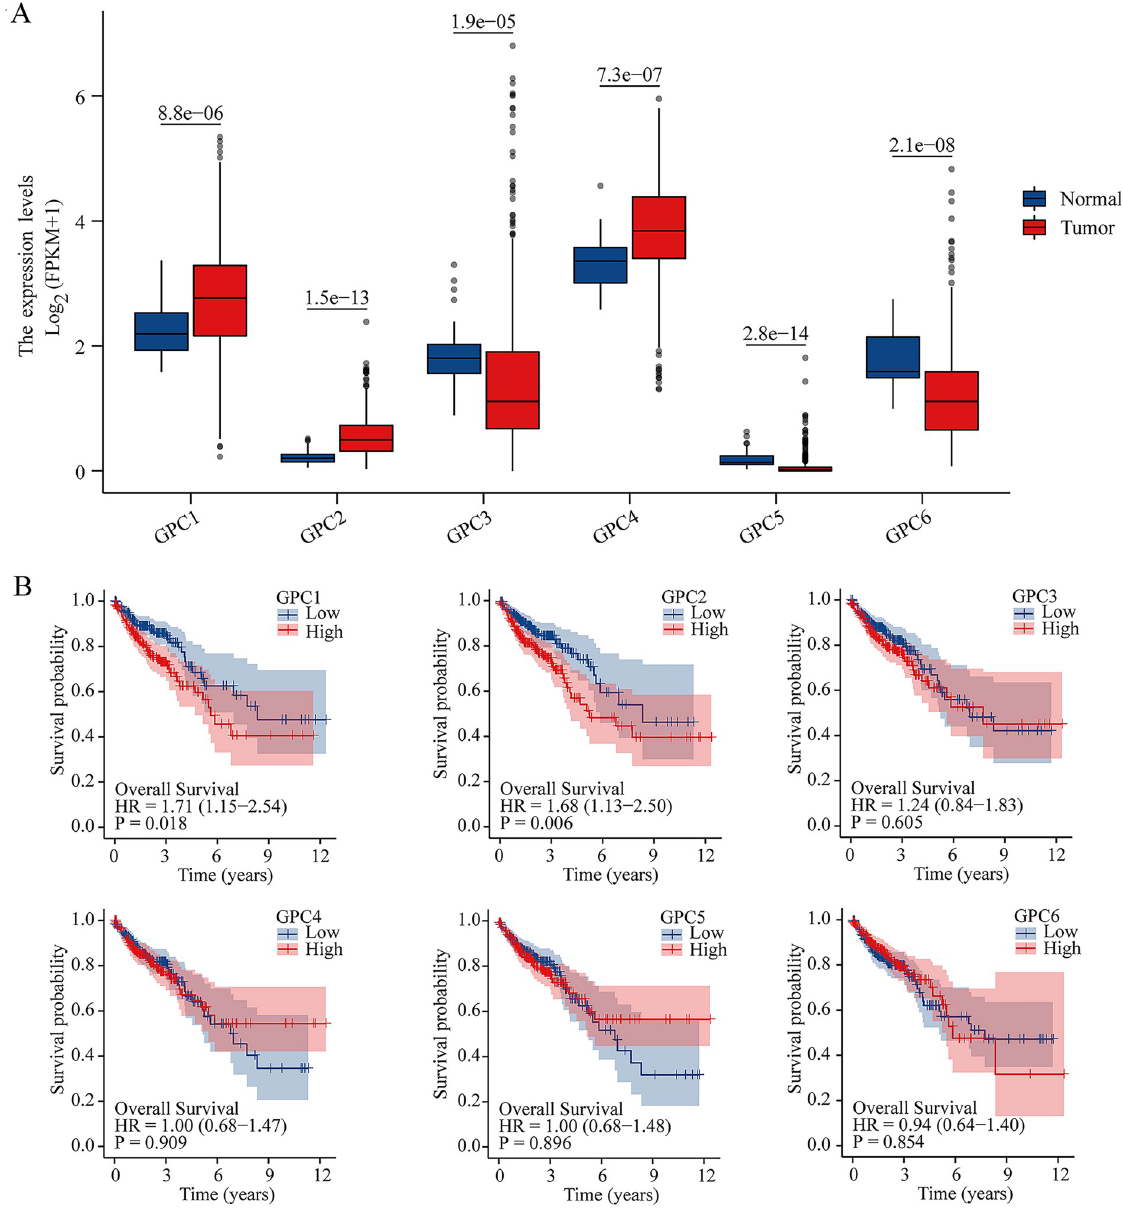
Fig 1. Differential expression of GPC family genes in colorectal cancer (CRC) patients. (A). Gene expression of six GPC family members in cancer tissues (473 samples) and non-tumor tissues (41 samples) in CRC patients (TCGA) using Student’s t test. Blue indicates non-tumor tissues, and red indicates CRC tissues. (B). Kaplan–Meier analysis revealed that CRC patients (453 samples, TCGA) with high GPC1 expression (225 samples, TCGA) and high GPC2 expression (225 samples, TCGA) had a poor prognosis compared with patients with low GPC1 and GPC2